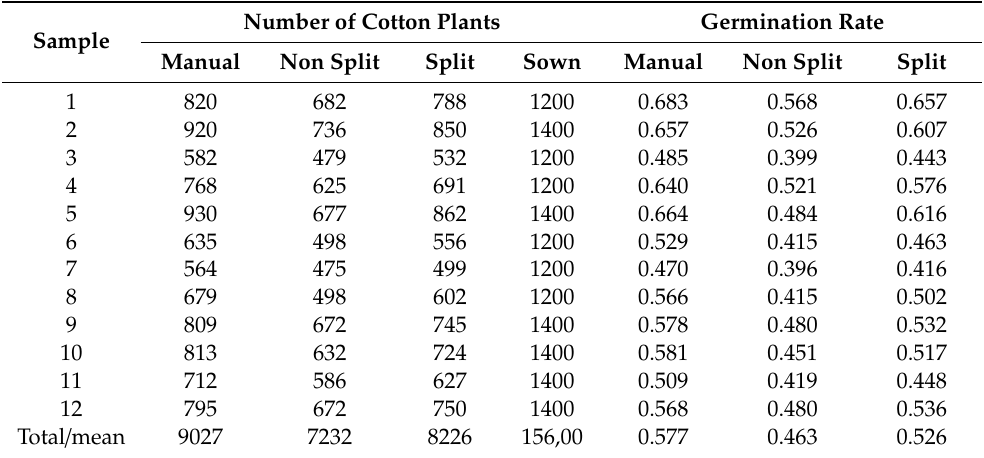
Table 3. The accuracy of cotton plant germination rate monitoring by the method used in this study.